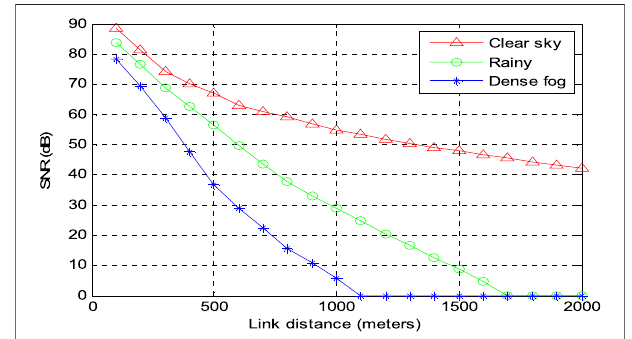
FIGURE 11 | Relationship between SNR and link distance for different meteorological conditions without link compensation.